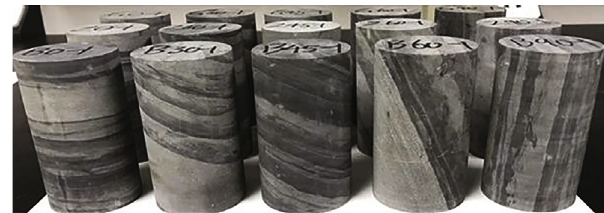
Figure 1: Schematic diagram of uniaxial compression samples of carbonaceous slate with di ff erent bedding inclination